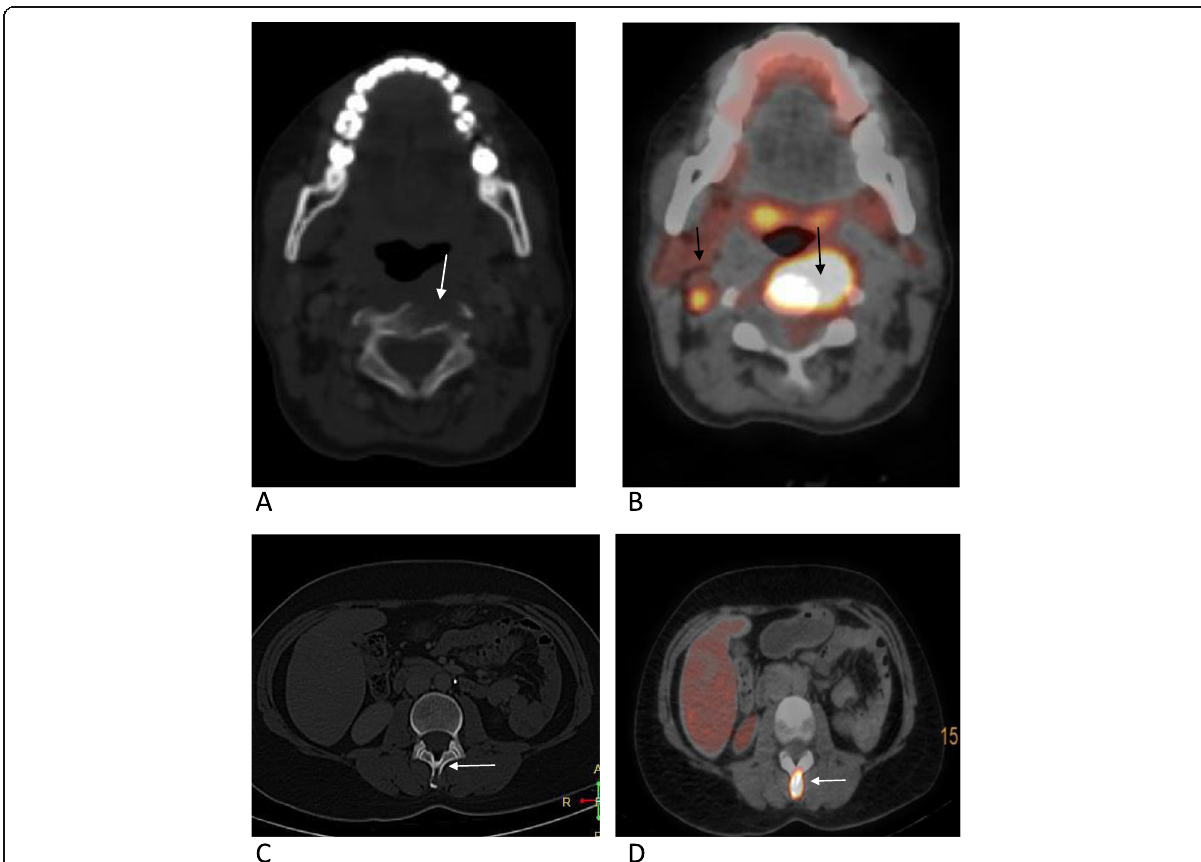
Fig. 7 A 38-year-old female patient who underwent rectal surgical resection for pathologically proven adenocarcinoma, not followed by chemo or radiotherapy. Recently, she presented with neck pain, low back pain, and elevated tumor markers level. a Axial CT image in bone window showing destructive cervical vertebral body lesion (arrow). b axial fused PET – CT image at the same level showing metabolically active lesion destroying the vertebral body of C2 as well as avid right deep cervical LN (arrows). c Axial CT image in bone window showing a small osteolytic lesion in the spinous process of the second lumbar vertebra (arrow). d Axial fused PET – CT image at the same level showing metabolic activity within the lesion of the spinous process of the second lumbar vertebra (arrow)